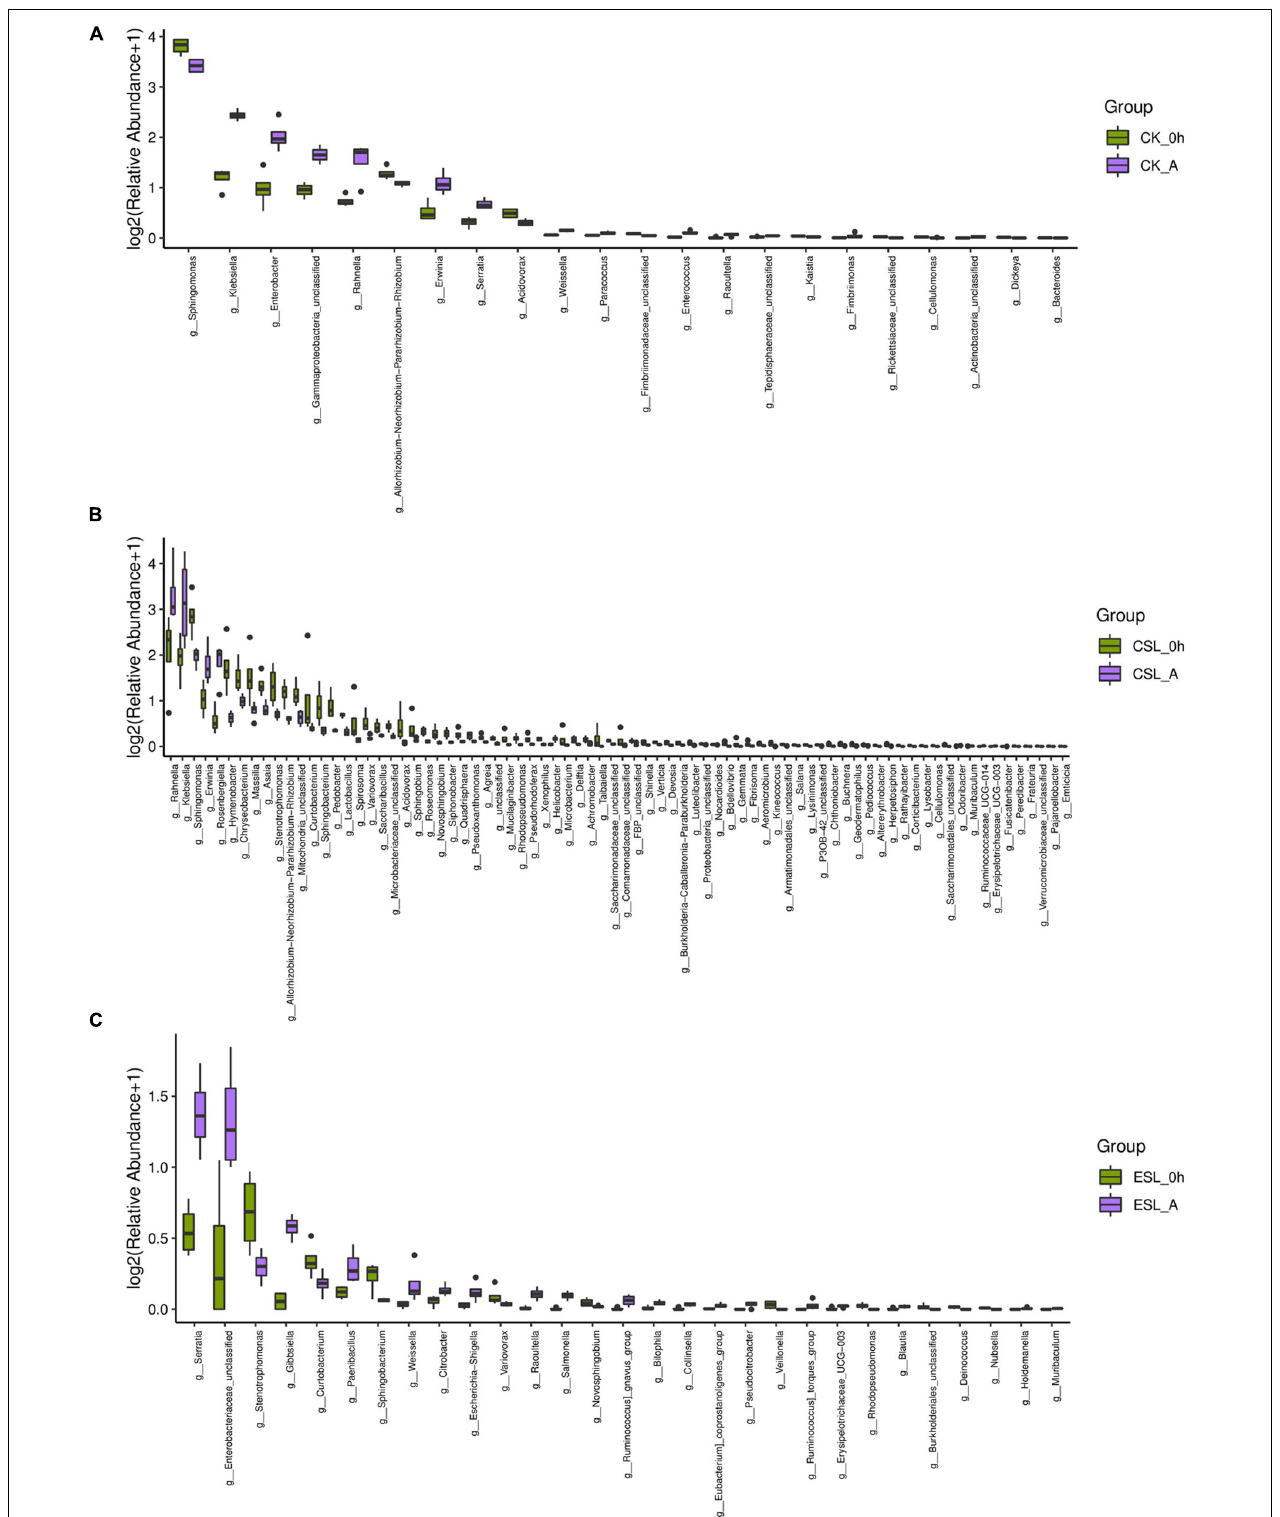
FIGURE 4 | Difference in bacterial communities (genus level) between before ensiling (0 h) and at anaerobic state (A) in whole-plant corn silages without any lactic acid bacterial suspensions (CK, A ), and treated with lactic acid bacterial suspensions prepared from whole-plant corn silage (CSL, B ) and from Elymus sibiricus silage (ESL, C